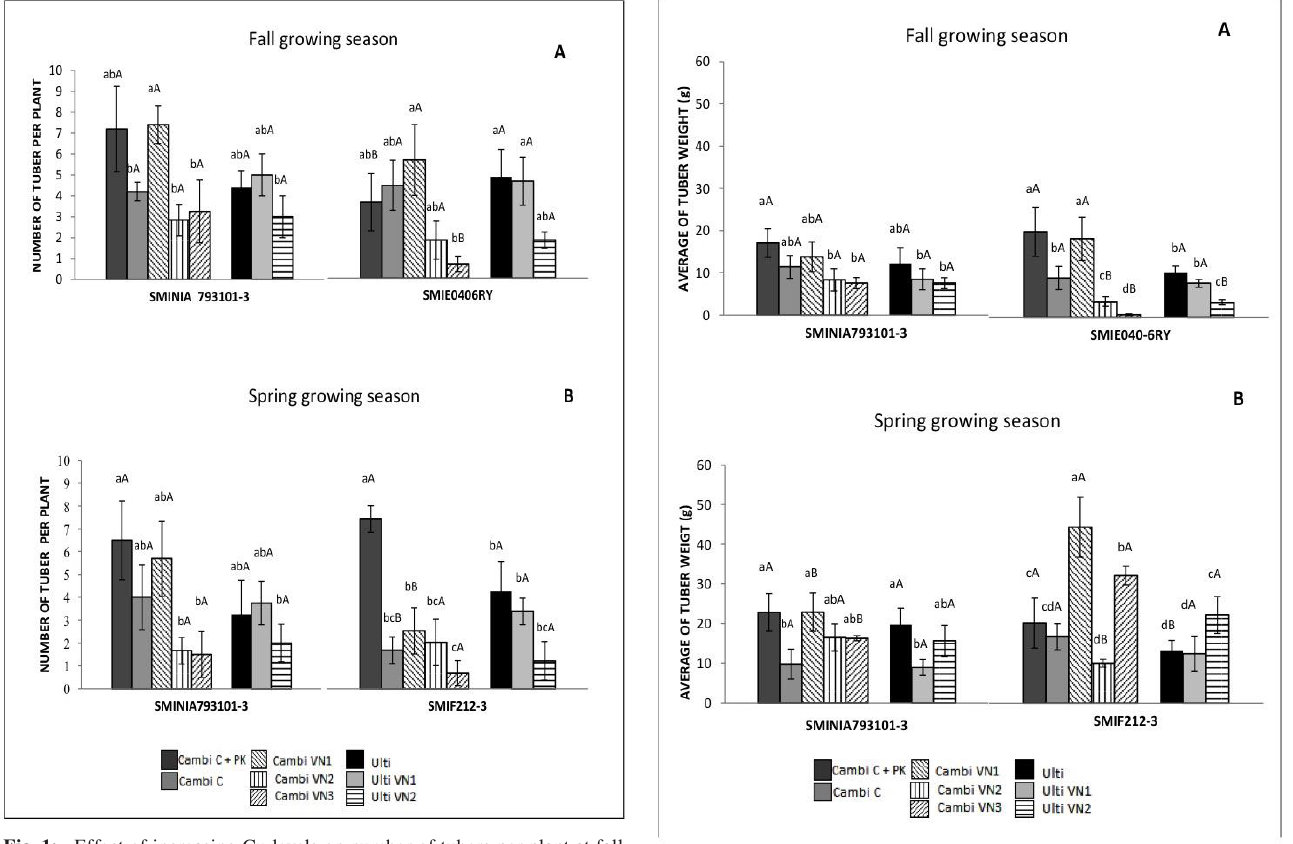
Fig. 2: Effect of increasing Cu levels on average of tuber weight at fall (A) and spring (B) growing seasons. Data represent the mean ± S.D. of six replicates. Different lowercase letters indicate significant differences between Cu levels in the same potato genotype and growing season (p < 0.05). Different capital letters indicate sig- nificant differences between potato genotypes at the same Cu level and growing season (p <